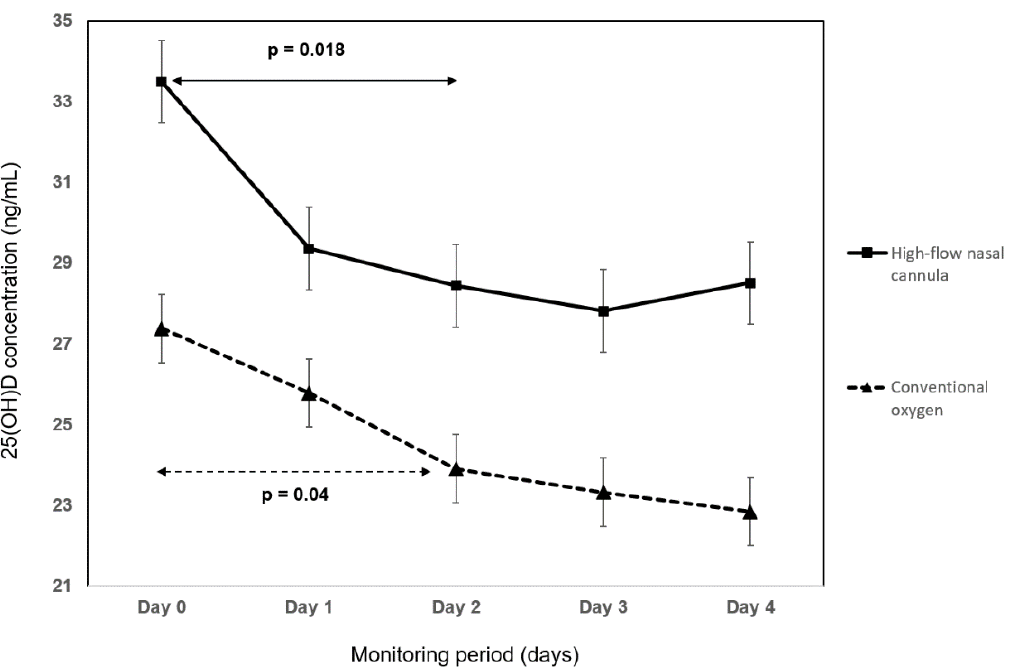
Figure 5. The kinetics of 25-hydroxyvitamin D (25[OH]D) concentration between patients treated with high-flow oxygen and conventional oxygen. p -values of the changes during the first 48 h are displayed.